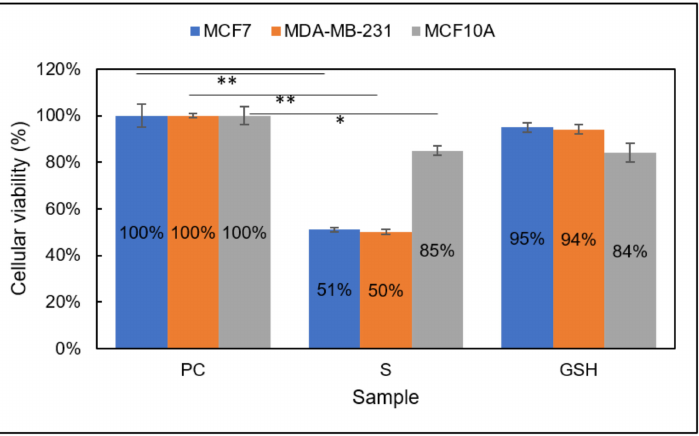
Figure 3. Cellular viability of MCF7 (blue), MDA-MB-231 (orange), and MCF10A (gray) cells analyzed using the MTT assay. Sample groups include: PC (untreated), S (Group 2), and GSH (functional control) cells. Data points represent the mean ± standard deviation. Statistical differences from the positive control are denoted by * p < 0.05, ** p < 0.01.